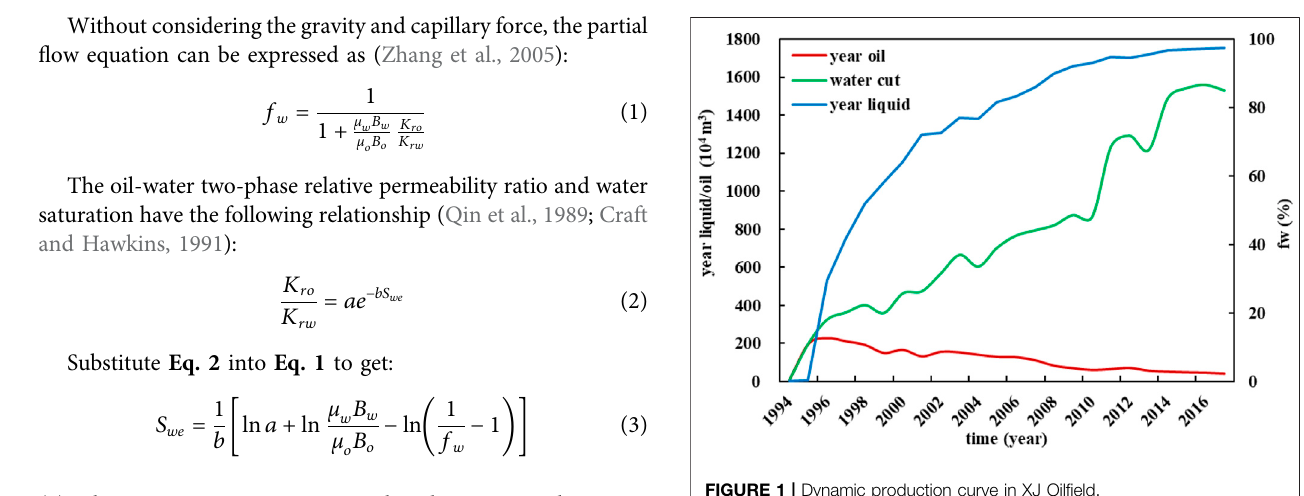
FIGURE 1 | Dynamic production curve in XJ Oil fi